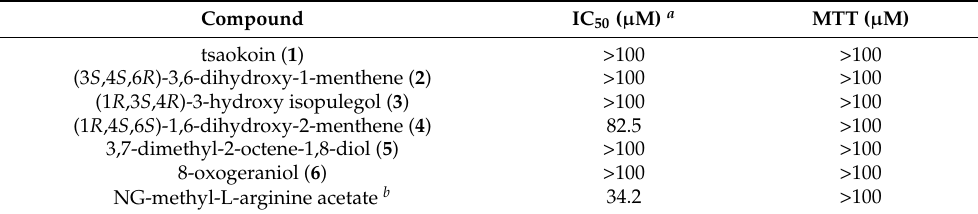
Table 2. Inhibitory effects of isolated compounds on LPS-induced NO production in RAW 264.7